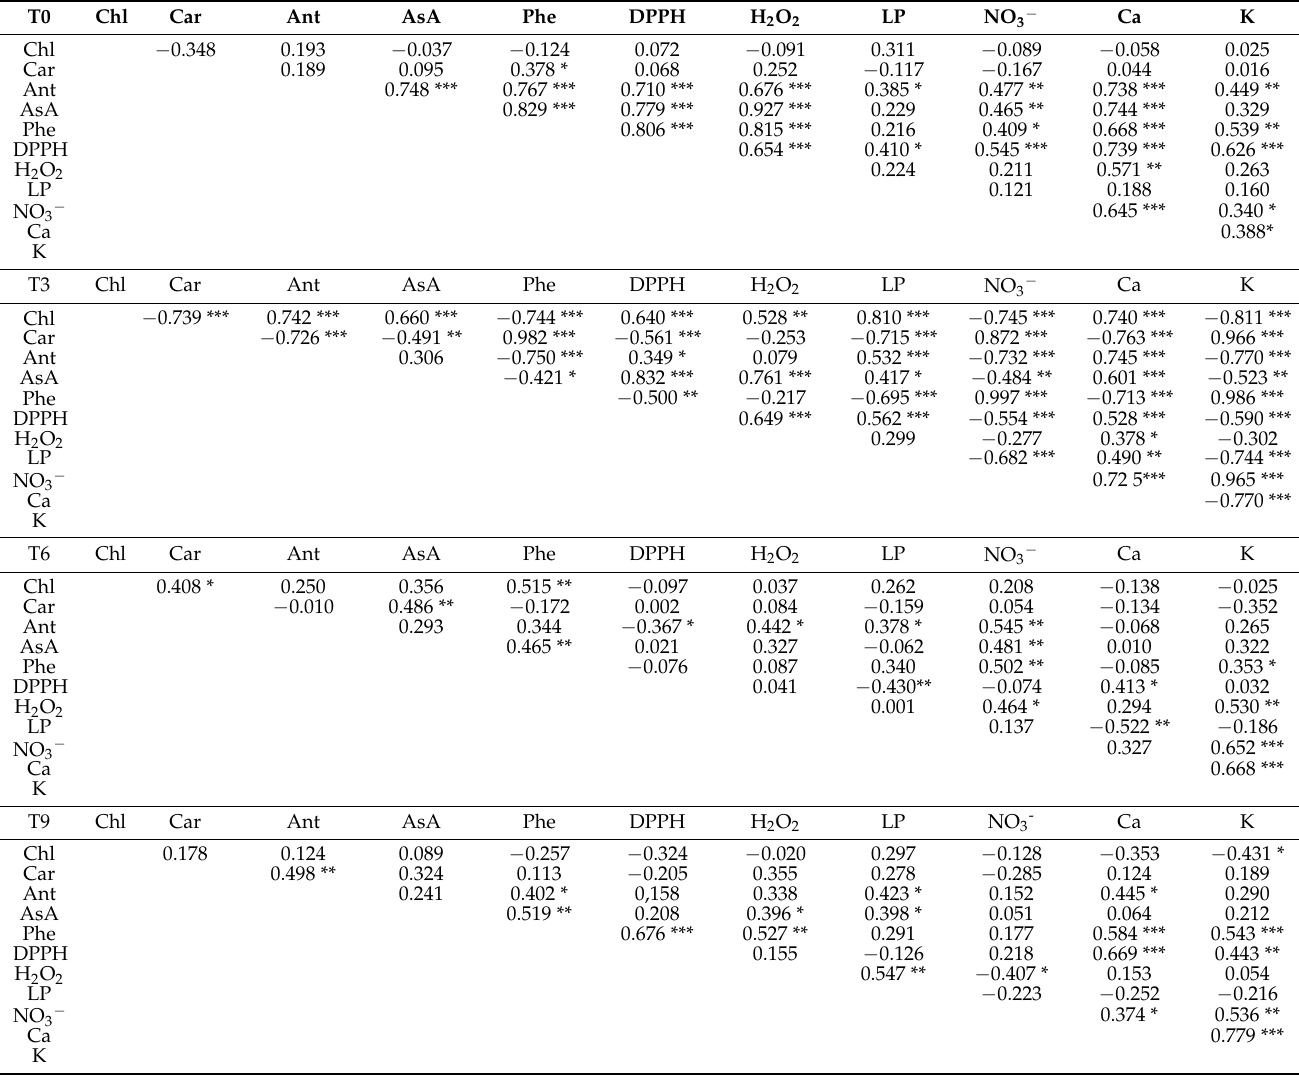
Table 6. Linear correlation coefficient (r) and its significance among the quality traits in the nine harvested lettuce varieties measured at 0 (T0), 3 (T3), 6 (T6) and 9 (T9) days after conservation under chamber conditions. ***, **, * indicate significance at p < 0.001, p < 0.01, p < 0.05 for r. Chl: Chlorophylls; Car: Carotenoids; Ant: Anthocyanins; Asa: Ascorbic Acid; Phe: Phenols; DPPH: Antioxidant capacity; H2O2: hydrogen peroxide; LP: lipid peroxidation; NO 3 − : nitrate; Ca: Calcium; K: Potassium.